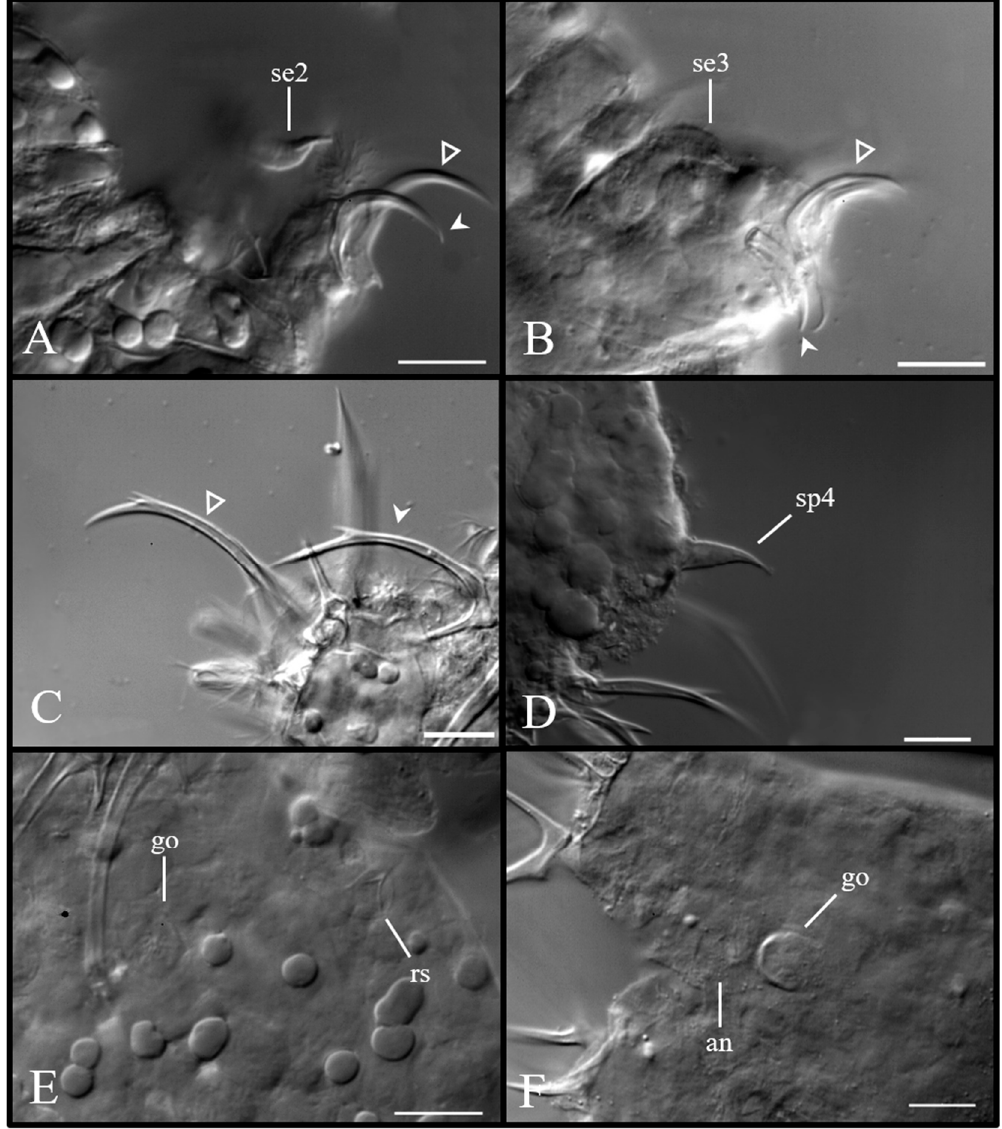
Figure 8. Coronarctus neptunus sp. nov. ( A ) Leg II, showing the sensory organ and the most external (indented arrowhead) and internal claws (empty arrowhead); ( B ) Leg III, showing the sensory organ and the most external (indented arrowhead) and internal claws (empty arrowhead); ( C ) Claws on legs IV, showing the accessory spines on internal claw (empty arrowhead) and external claw (indented arrowhead); ( D ) Coxal process on legs IV; ( E ) Female gonopore and seminal receptacle; ( F ) Male gonopore and anus. Abbreviations: an—anus; go—gonopore; rs—seminal receptacle; se2–3—sensory organ legs II–III; sp4—coxal process on leg IV. Scale bars: 10 µm.